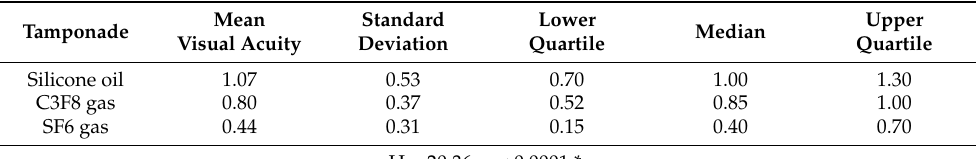
Table 2. Values of the visual acuity (mean, standard deviation, median, lower and upper quartile) in logMAR in eyes treated with different tamponades (silicone oil, SF6 gas, and C3F8 gas) in the group operated on with the conventional microscope. Tamponade